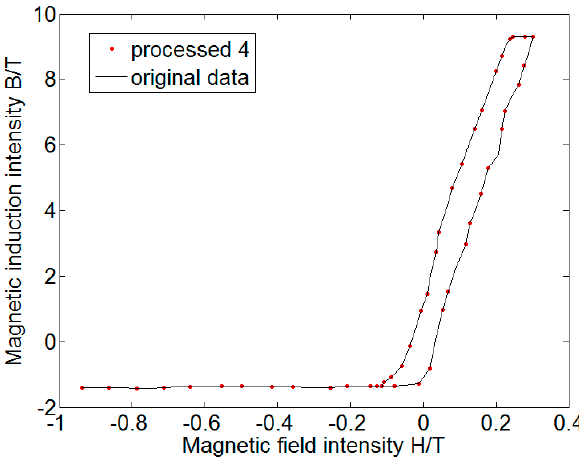
Figure 12. Fitting curve and the original experimental data curve. “Processed 4” represents the fitting curve through the BP neural network based on a genetic algorithm. “Original data” represents the original experimental data.